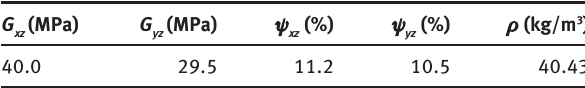
Table 3: Nomex honeycomb core elastic and damping data [15].